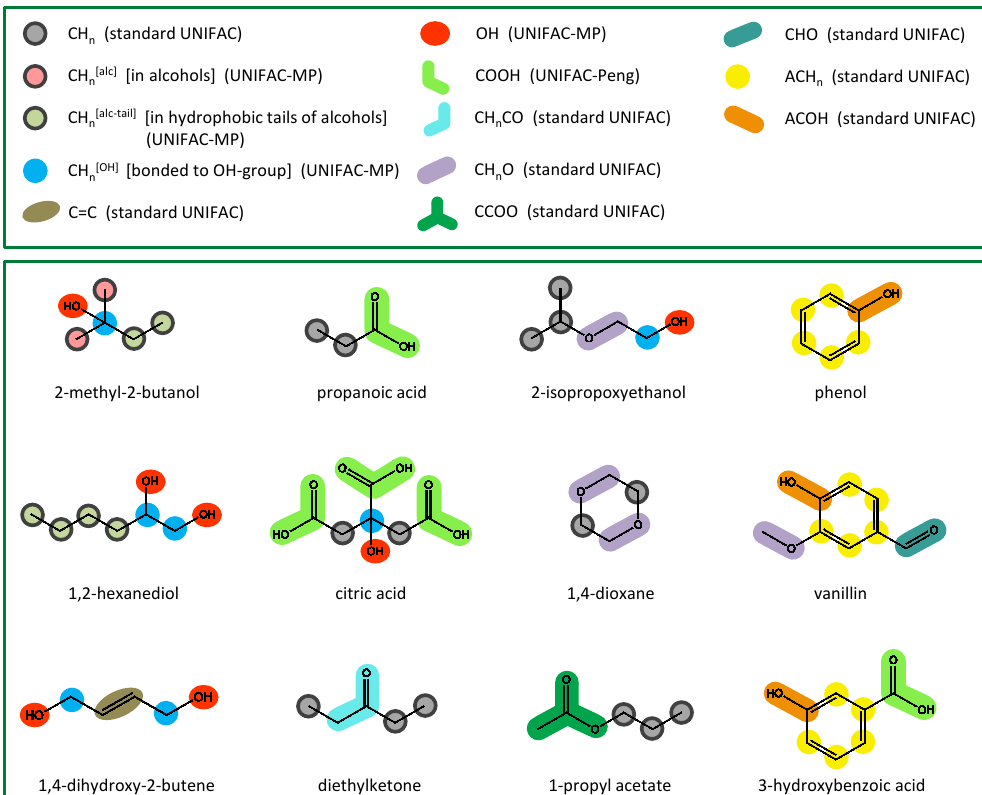
Fig. 1. Upper box: complete list of types of organic functional main groups used in AIOMFAC. AIOMFAC follows the UNIFAC naming convention for functional groups (see also Fig. 8). Besides the functional groups and associated interaction parameters of standard UNIFAC (Hansen et al., 1991), specific groups of Marcolli and Peter (2005) (UNIFAC-MP) and of Peng et al. (2001) (UNIFAC-Peng) are used as indicated. AIOMFAC middle-range main group ↔ ion interactions involving the specific alkyl groups CH [ alc ] alcohols] and CH n [in alcohols, (but not in hydrophobic tail nor bonded to OH group)] are described with the same parameters as CH n (standard UNIFAC) ↔ ion interactions, denoted by the common outline color. Lower box: